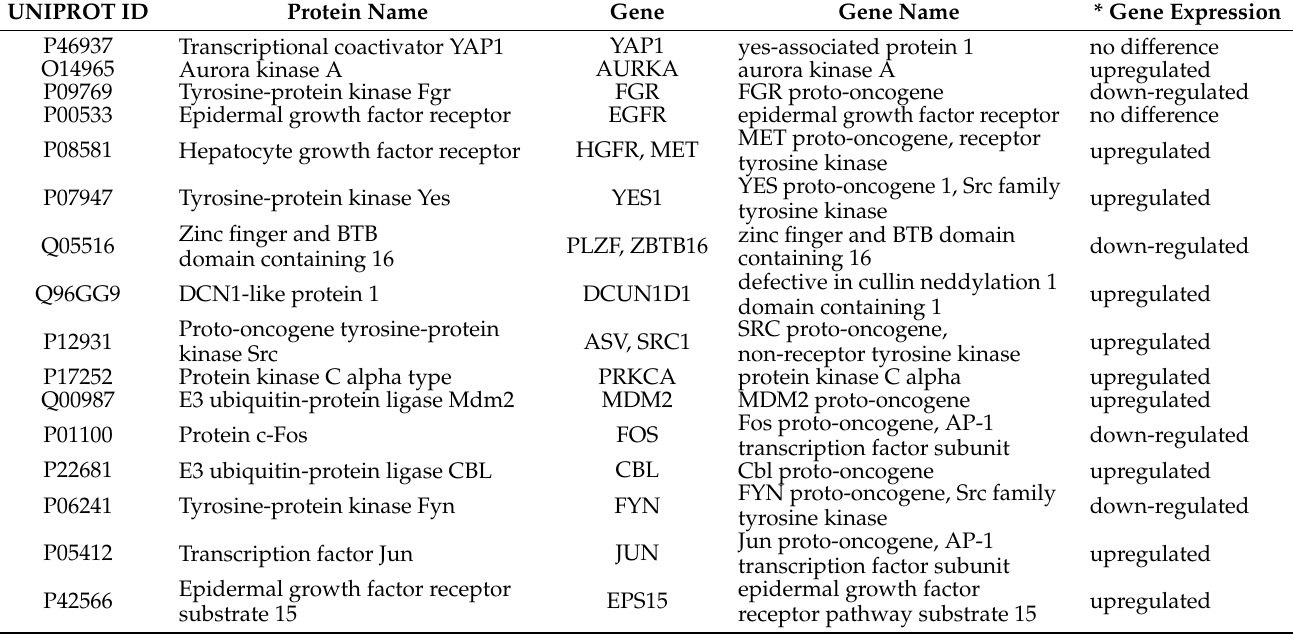
Table 2. List of targets and their expression in